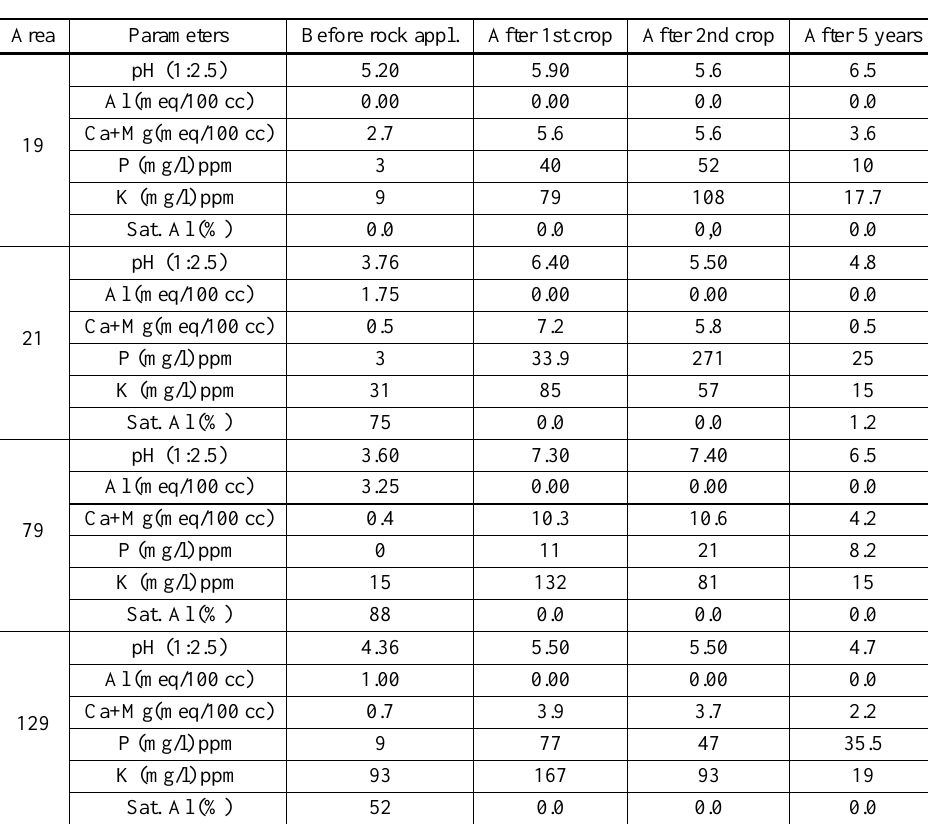
Soilfertilityanalysisofsoilsamplesbeforeandafterrockfertilizerapplication. Source: (S.M.C.H. Theodoro, unpublished data and Theodoro and Leonardos 2004). Area Parameters Before rock